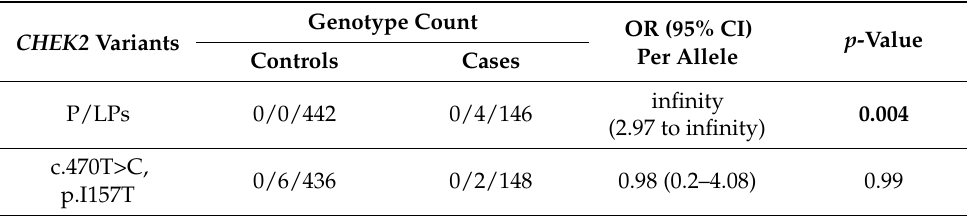
Table 2. Enrichment analysis: frequency of CHEK2 variants identified in Croatian prostate cancer patients compared to cancer-free Croatian men. P/LPs: pathogenic and likely pathogenic variants